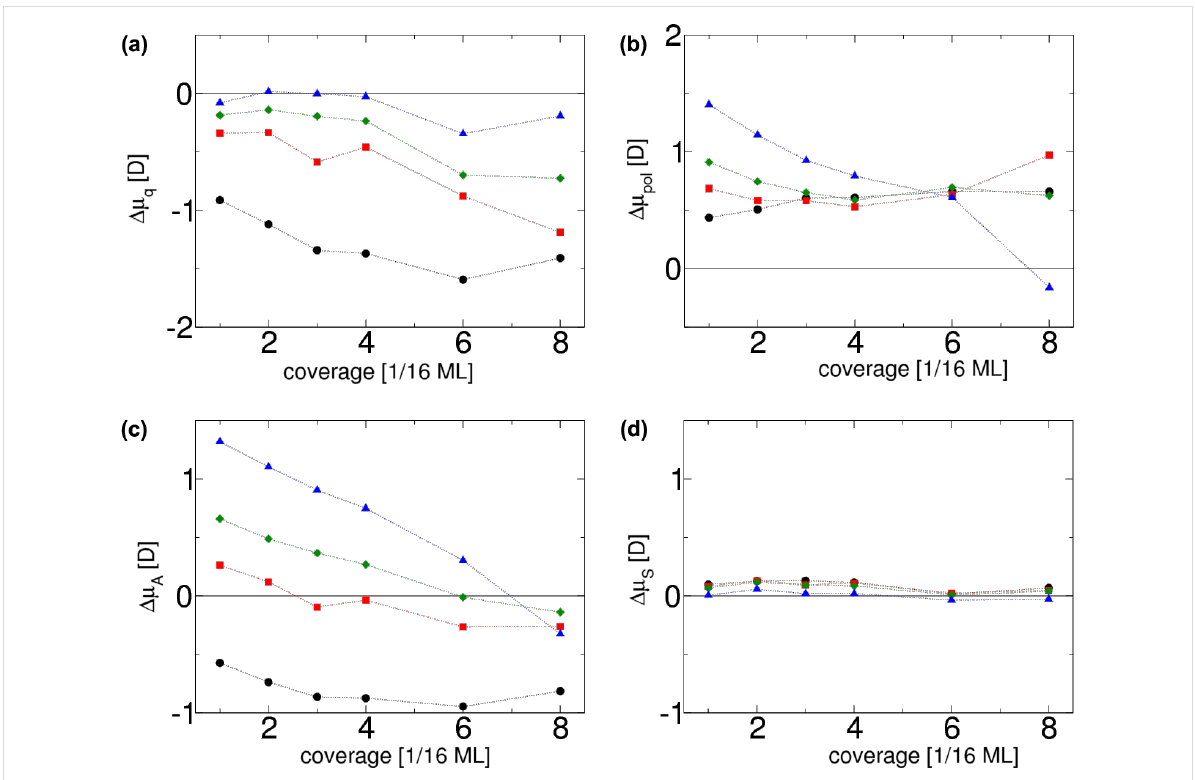
Figure 6: Contributions to the total dipole moment change Δ μ according to Equation 6 and Equation 7 as a function of halogen coverage. The term Δ μ q describes the purely charge transfer induced dipole moment and Δ μ pol the polarization induced dipole moment; Δ μ A shows the effect of the adsorbate layer on the total dipole moment and Δ μ S indicates substrate effects. The color code denoting the different halogen atoms is the same as used in the previous